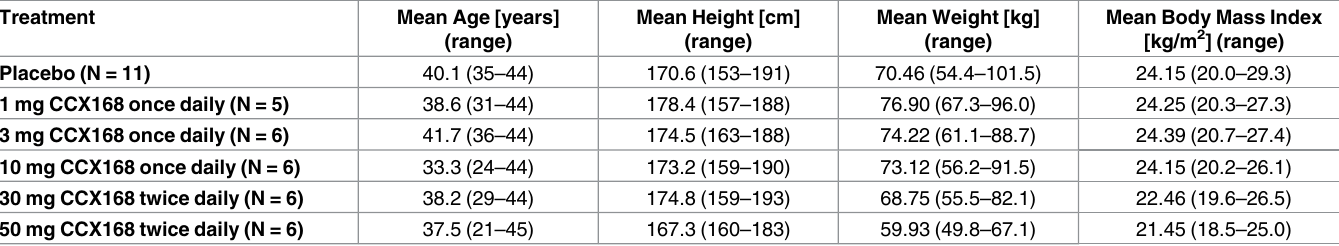
Table 2. Demographic Data for Subjects in Period 2 of the Phase 1 Clinical Study (Mean, Min—Max). Treatment